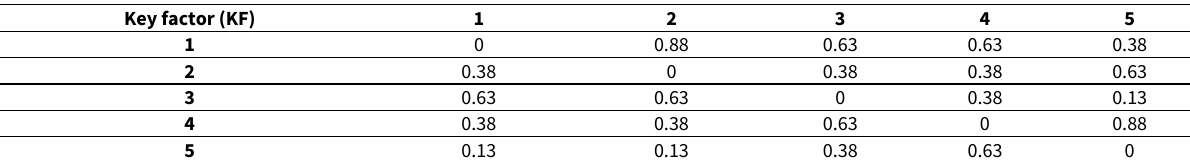
Figure 3. Outcomes for the micro-level Table 1. FCM Matrix